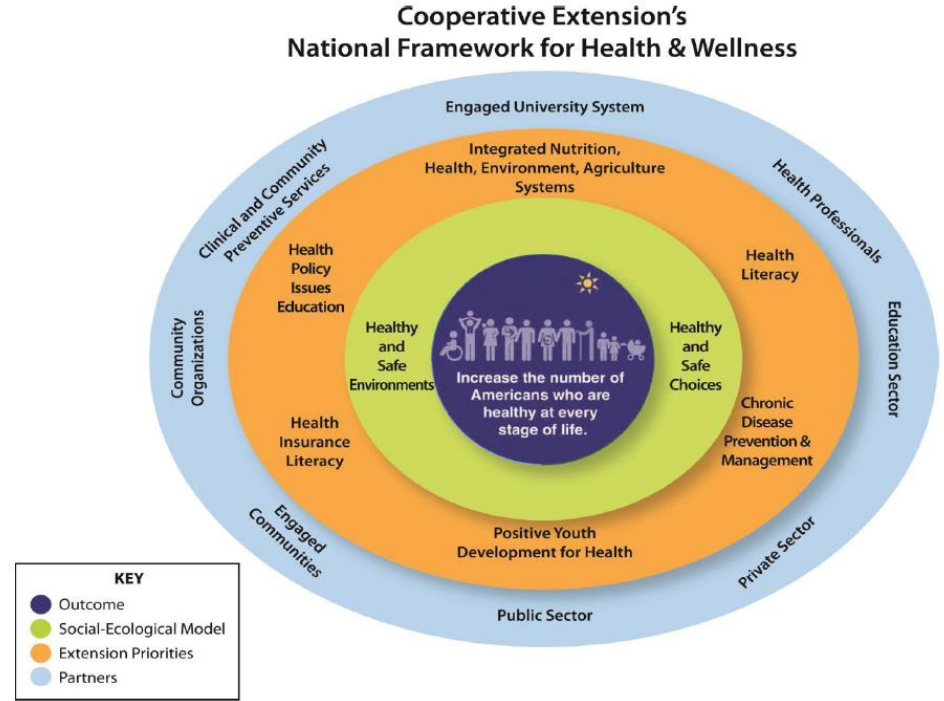
Figure 1. Cooperative Extension’s National Framework for Health and Wellness. Note: This frame- work uses an adapted social-ecological model to present the interplay between outcome, goal, environments, priorities and partnerships. Reprinted with permission from Ref. [7]. Copyright 2015 Extension Journal, Inc.